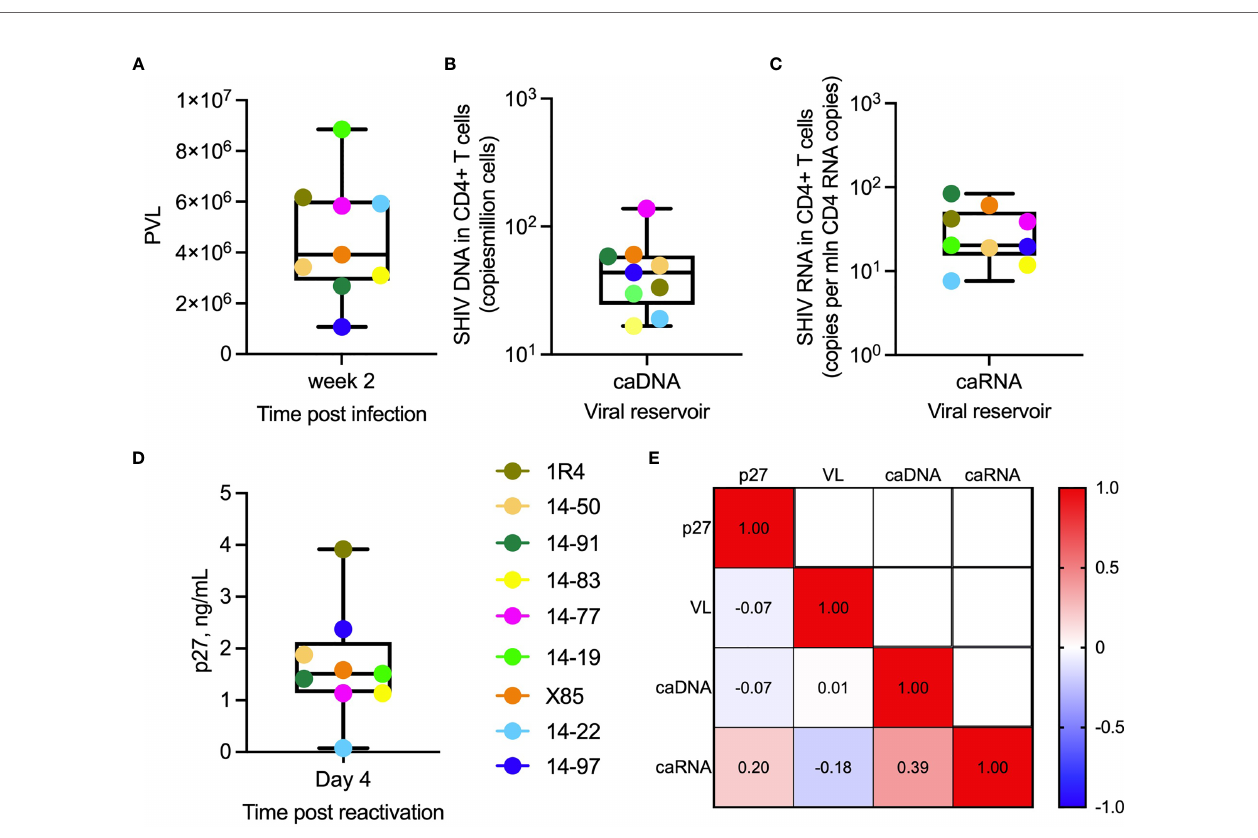
FIGURE 3 | Virologic parameters. (A) Plasma viral load (SHIV RNA copies/mL) in individual animals (indicated by their ID designations) following 2 weeks post infection with SHIV.CH505.375H. (B) Cell-associated viral DNA (caDNA) and (C) cell-associated viral RNA (caRNA) prior to ART initiation at week 16 post-infection. (D) SIV Gag p27 levels in supernatants of primary RM CD4+ T cells collected at week 2 post-infection, activated for 24 hours in vitro with anti-CD2, CD3, and CD28 antibodies and cultures for 3 days in fresh media. (A – D) In the box plots, horizontal lines within boxes denote median values, ends of boxes denote 25 th and 75 th percentiles, and lines outside of boxes denote minimum and maximum values. (E) Spearman correlation analysis of p27 levels in supernatants following in vitro activation of RM CD4+ T cells, peak plasma viral load, cell-associated viral RNA, and cell-associated viral DNA. Values are R 2